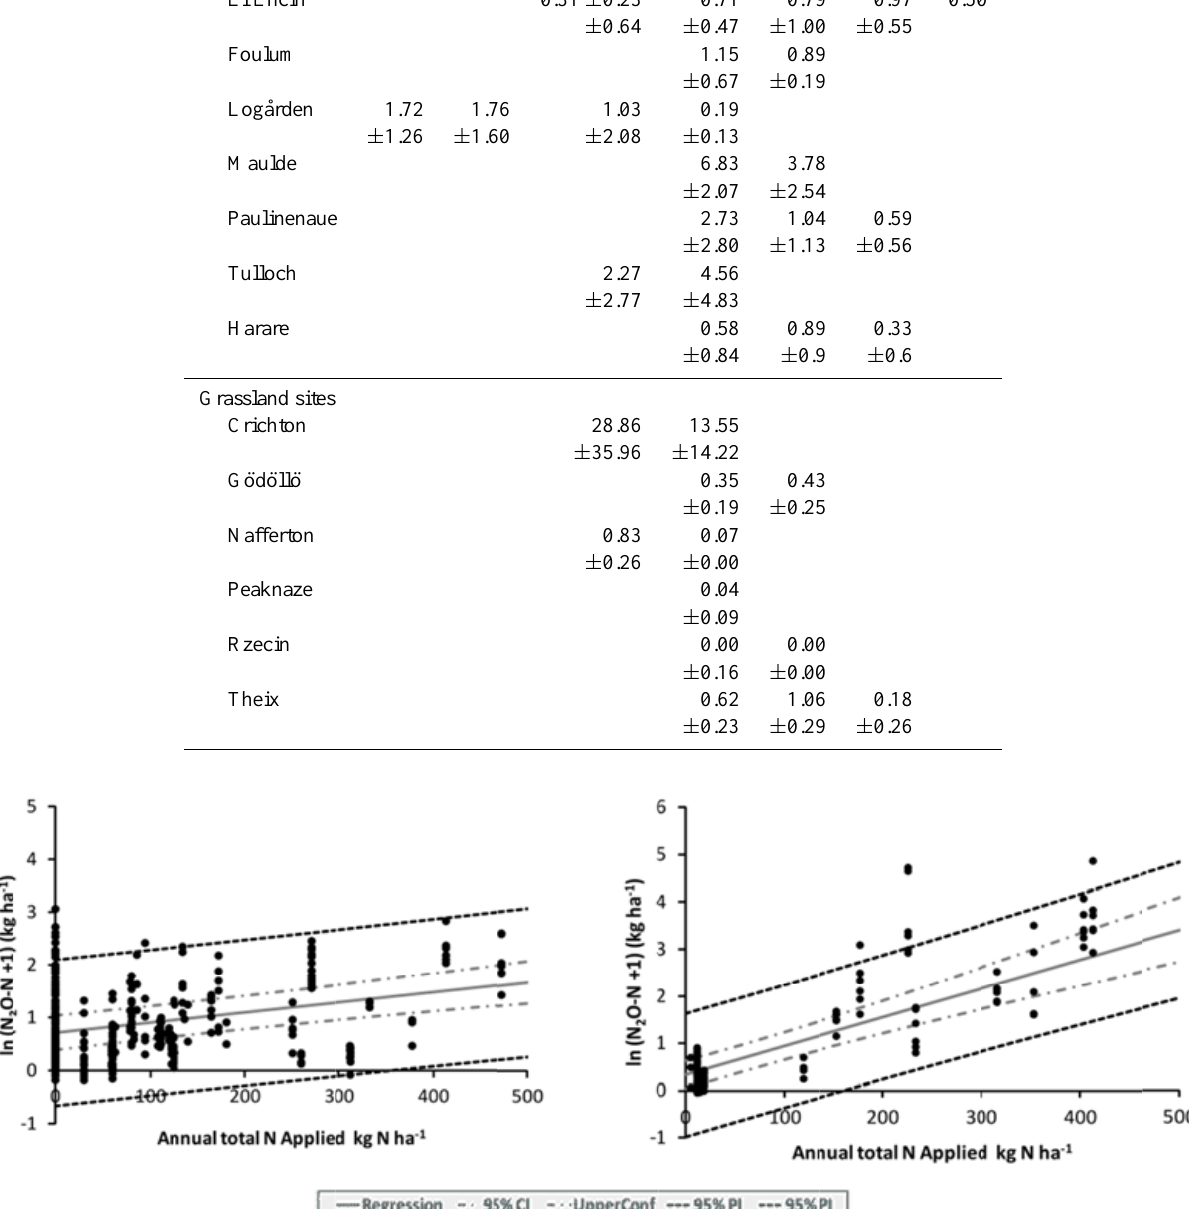
Fig. 3. The relationship between N 2 O emissions and added N input (in the form of organic manures and synthetic N fertiliser) for (a) arable sites and (b) grassland sites. Ln(N 2 O) (kgN 2 O-Nha − 1 ) . The data set includes multiple data points from each